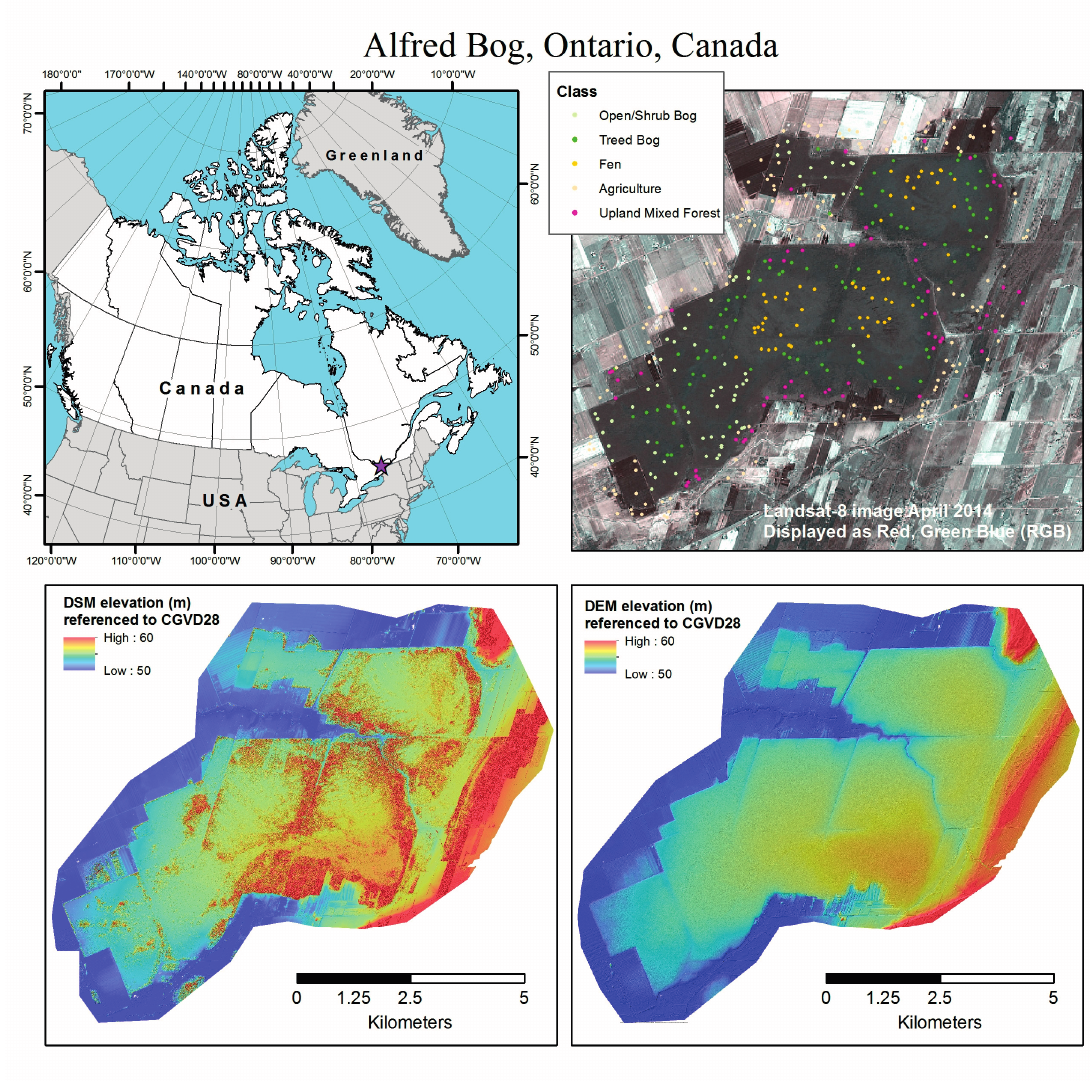
Figure 1. Study area map. Top left shows location within Canada (purple star). Top right shows Landsat-8 4-3-2 red/greed/blue image with training data points overlain. Bottom left shows LiDAR Digital Surface Model (DSM). Bottom right shows LiDAR Digital Elevation Model